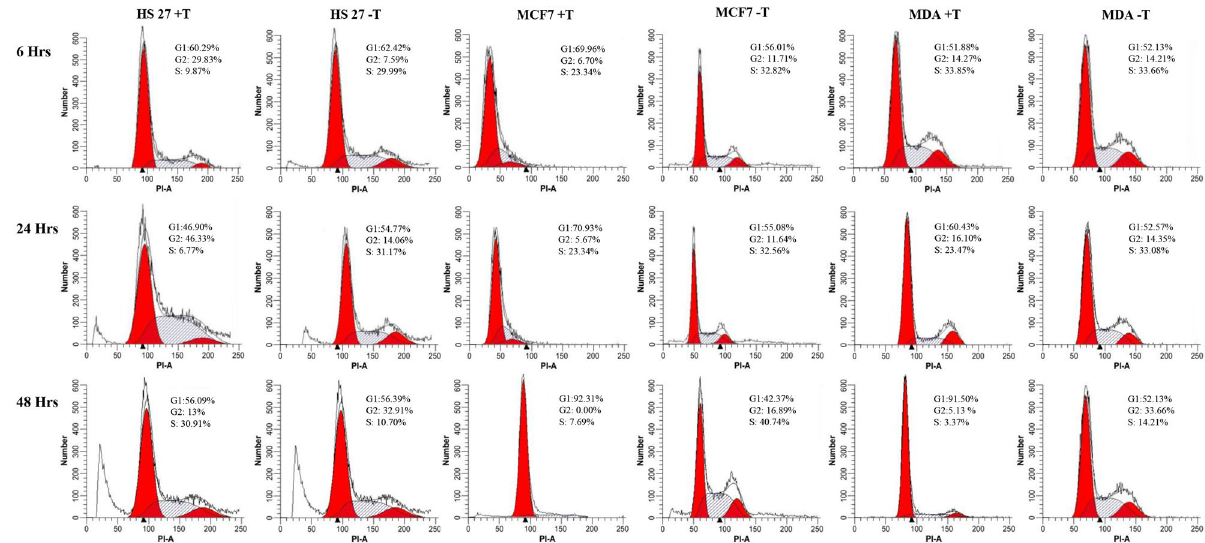
Figure 6. Cell cycle profile for cells after treatment with F2. (+ T) treated sample, (− T) untreated sample.